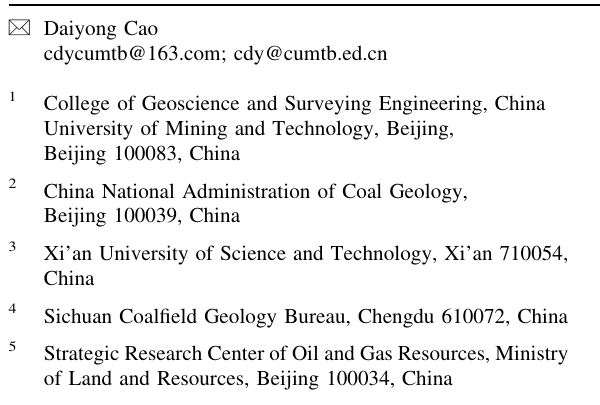
Fig. 1 Tectonic framework of coalfields in China. 1— Paleogene–Neogene coal measure; 2—Lower Cretaceous coal measure; 3—Early-Middle Jurassic coal measure; 4— Upper Triassic coal measure; 5—Carboniferous–Permian coal measure; 6—First-level structural boundary; 7—Se- cond-level structural boundary; I: Eastern compound deformation zone; II: Western compressional deformation zone; III: Middle transitional deformation zone;